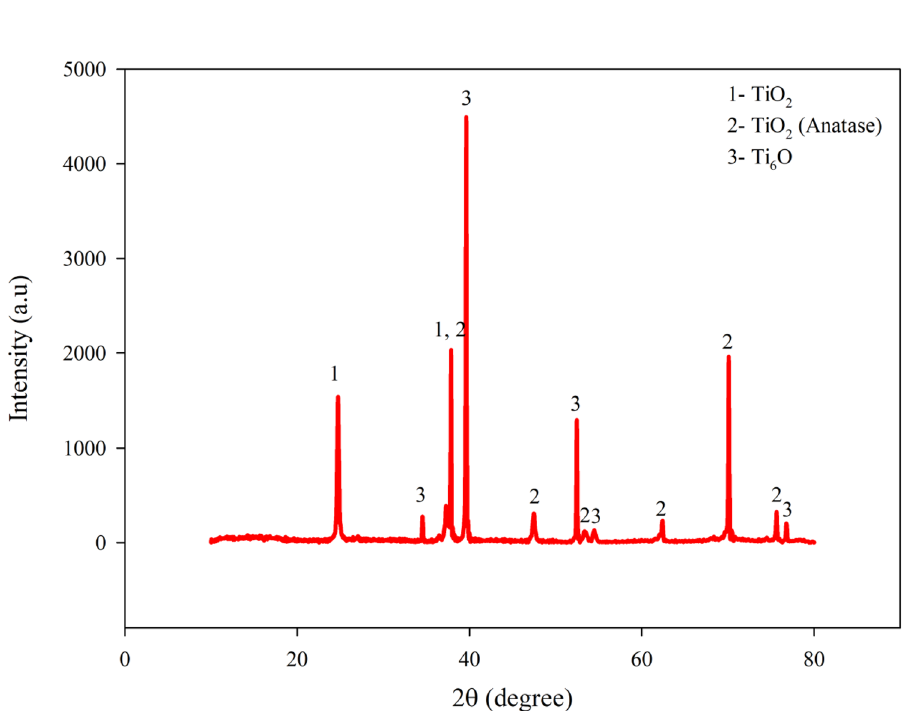
Figure 3. XRD spectra of AgNPs-deposited (Gr2-50 V-Ag-5 m) nanotube